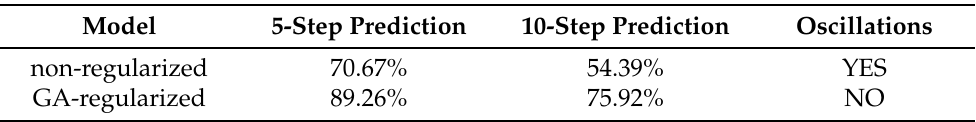
Table 4. Prediction ability of the GA regularized model combined with the averaged non-regularized